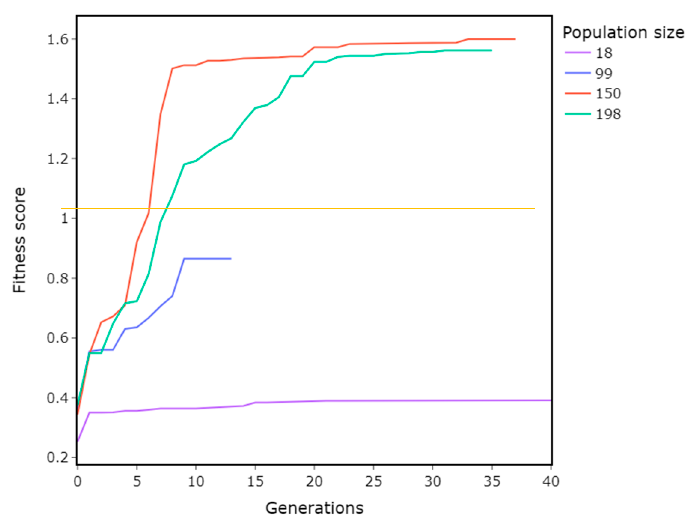
Figure 5. Impact of population size on the GA’s performance. Higher population sizes show better performance in terms of the fitness score. The population size of 150 shows the best